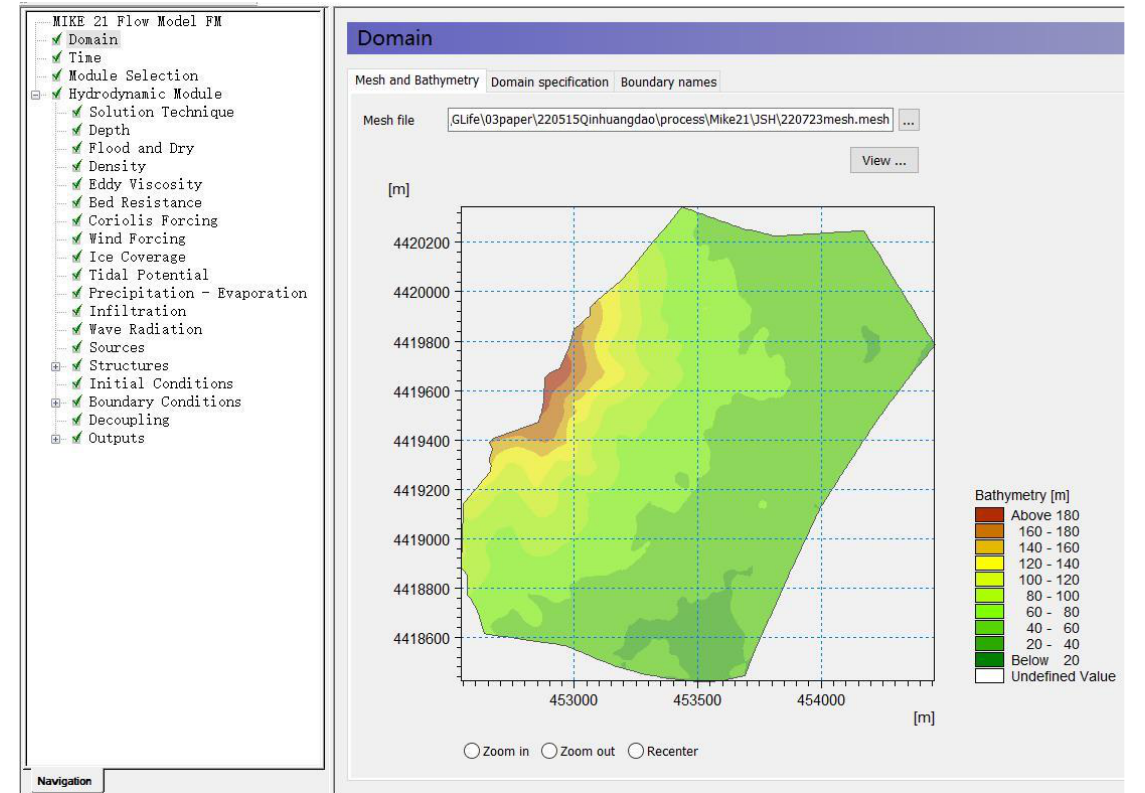
Figure 7. MIKE 21 model built after site construction. Note: when the MIKE 21 model simulates flow velocity and submerged area, its rainfall and evaporation parameters are set differently. Notes: MIKE 21 Flow Model FM is a modelling system based on a flexible mesh